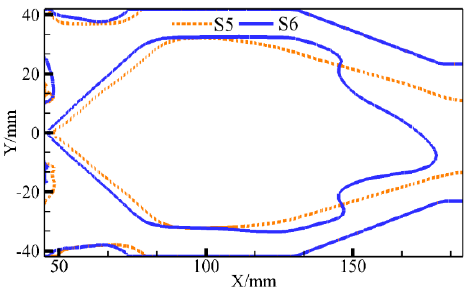
Figure 13. The shape of PRZ under Schemes S5 and S6.